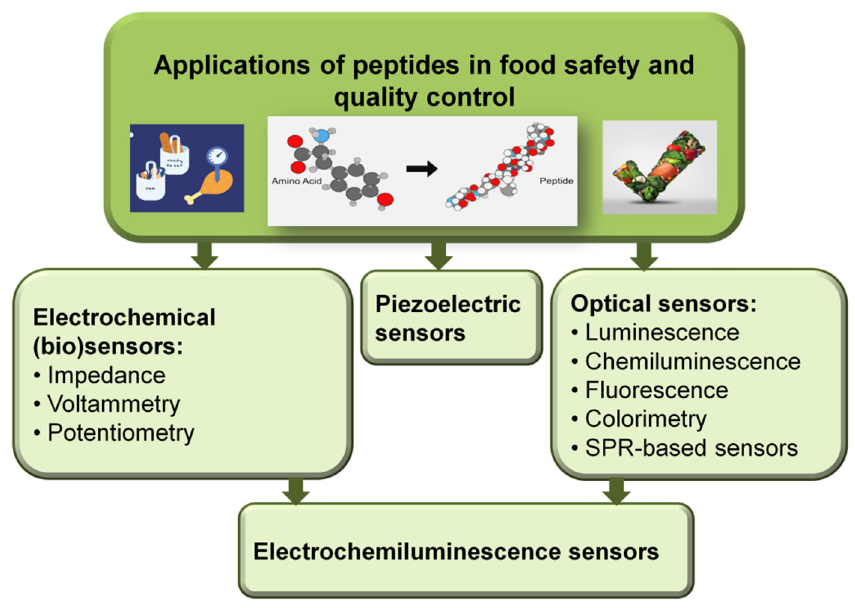
Figure 3. Overview of peptide-based sensors applications in food safety and quality